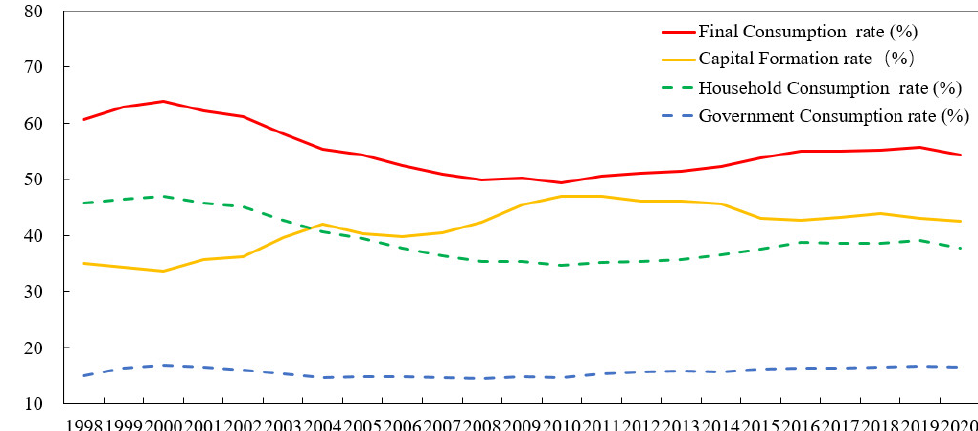
Figure 1. Final consumption rate (%) and capital formation rate (%) in China, 1998–2020. Source: The National Bureau of Statistics.